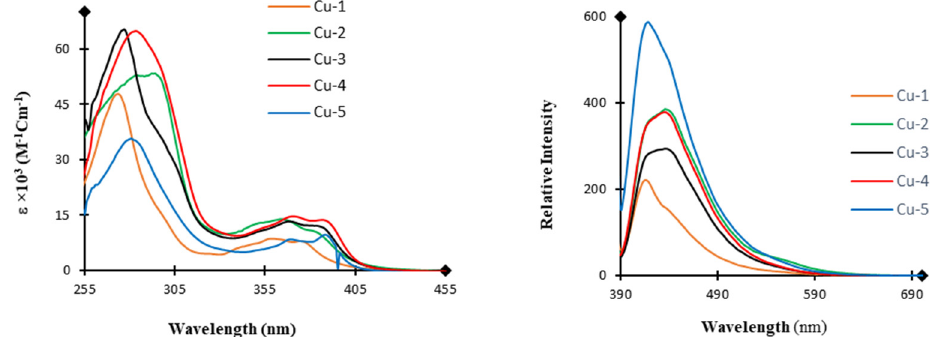
Figure 4. Unit cell packing diagram for Cu-1 .